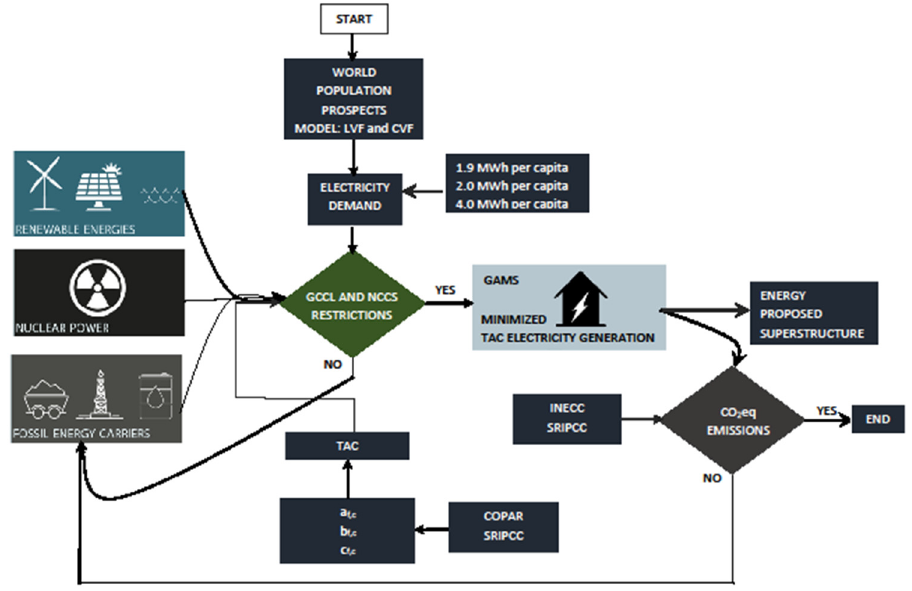
Figure 4. Schematic representation of Mexican Electricity System (MES) optimization .